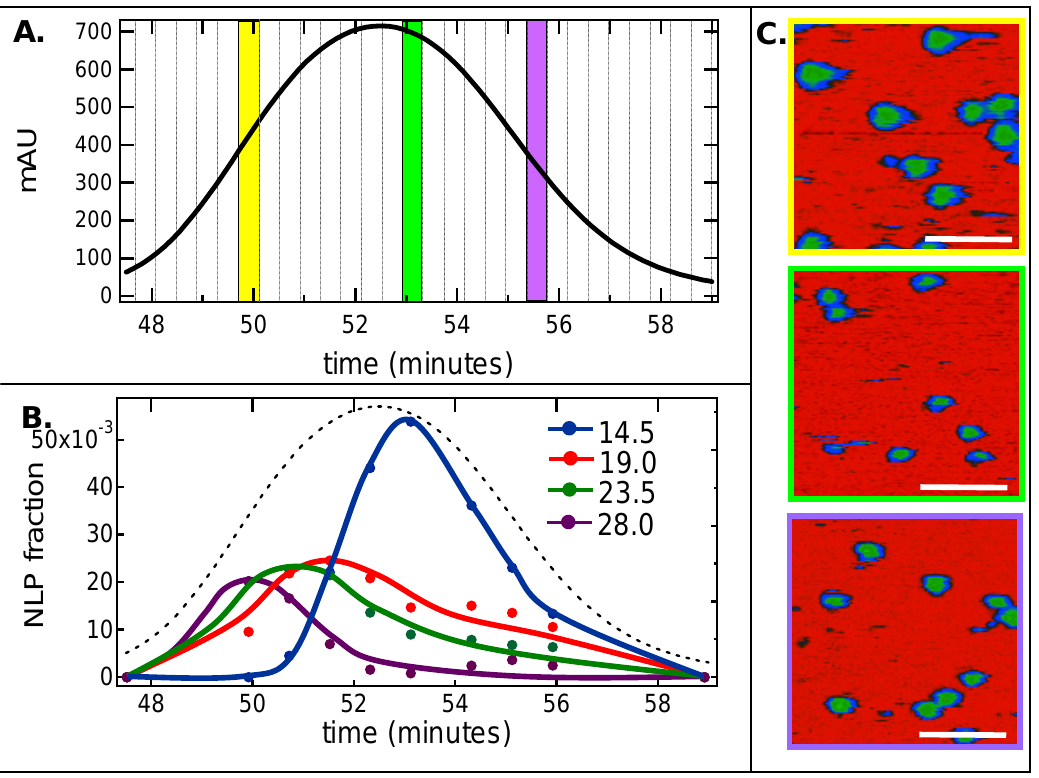
Figure 2. AFM analysis of SEC fine elution fractionation vs. volume purification. A. An expanded view of the NLP-rich peak under cholate-free assembly conditions. Dashed lines indicate the fractions in which elutions were collected. B. Relative proportion of the four different sized NLPs in the SEC fine elution fractions. Dashed line represents SEC trace. C. Representative AFM images from the fractions highlighted in A., highlighted color of the fraction correspond to the images with the same colored border. Scale bar 100